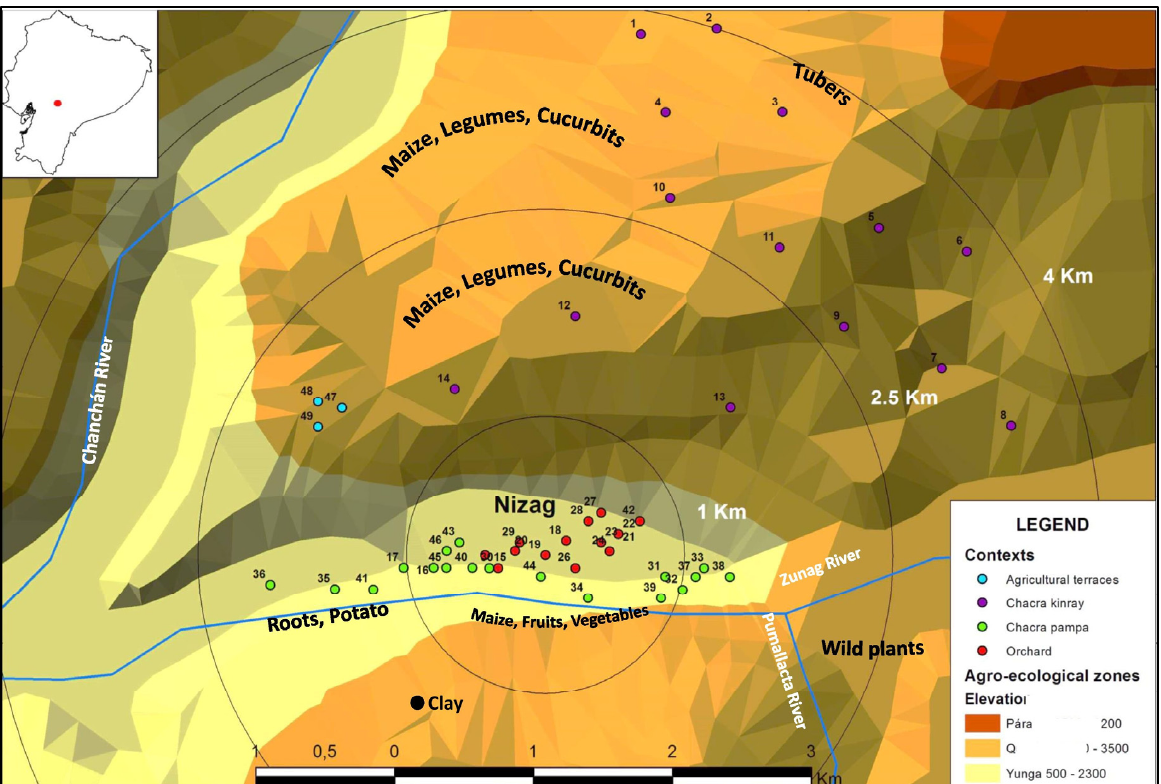
Figure 8. The agricultural catchment area of the Nizag community. (1–14) Interview sites in the Chacras Kinray; (15–30); Interview sites in the Chacras pampa; (31–46); Interview sites in the Or- chards; (47–49) Interview sites in the Agricultural